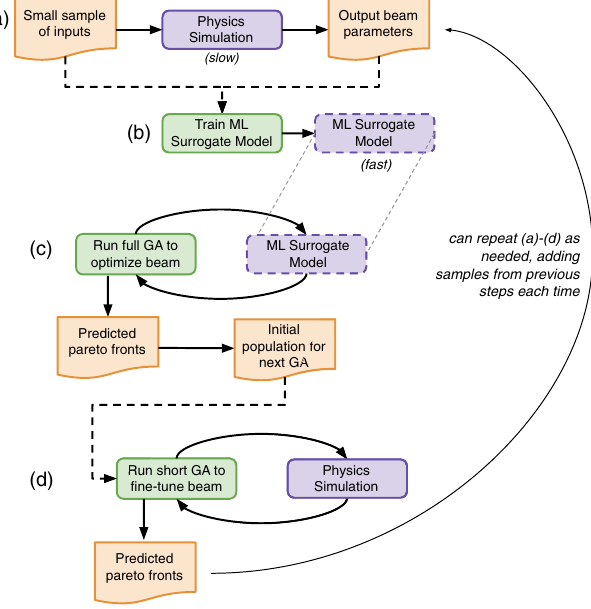
FIG. 8. Workflow for a method to obtain orders of magnitude faster GA optimization of particle accelerators. First, run a small random sample of inputs through the physics simulation (e.g., a few hundred points in our case) (a). Train an ML model on the random sample (b). Run the GA with the ML model to obtain predictions of the estimated Pareto front and corresponding optimal input settings on the machine (c). Use the predicted optimal input settings as the initial population in a second, shorter GA optimization over the physics simulation to fine-tune the result (d). One can also incorporate the new data into a second training of the ML model and repeat these steps as needed until convergence (i.e., iterative retraining and